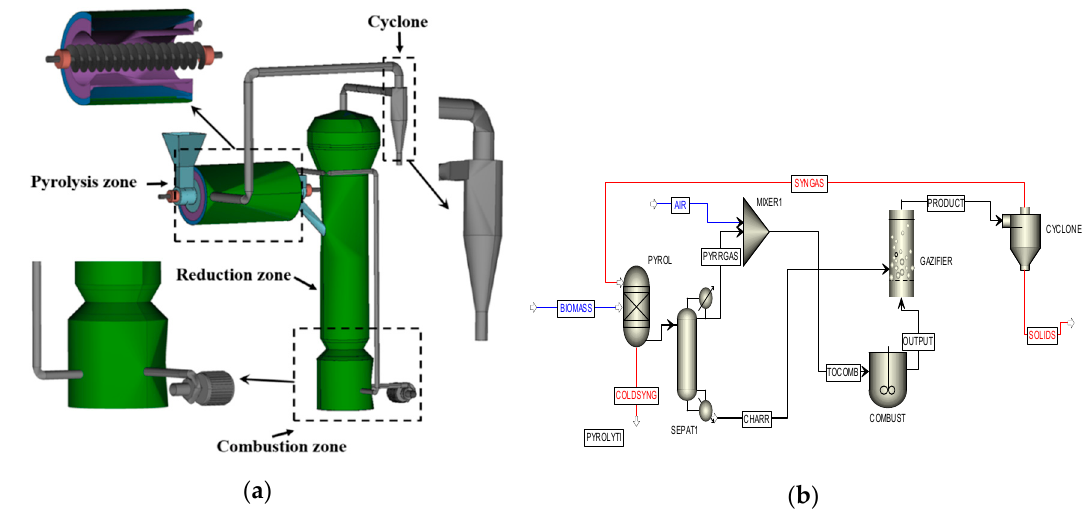
Figure 1. ( a ) 3D schematic of the multistage gasifier and ( b ) flowsheet of the Aspen Plus model.